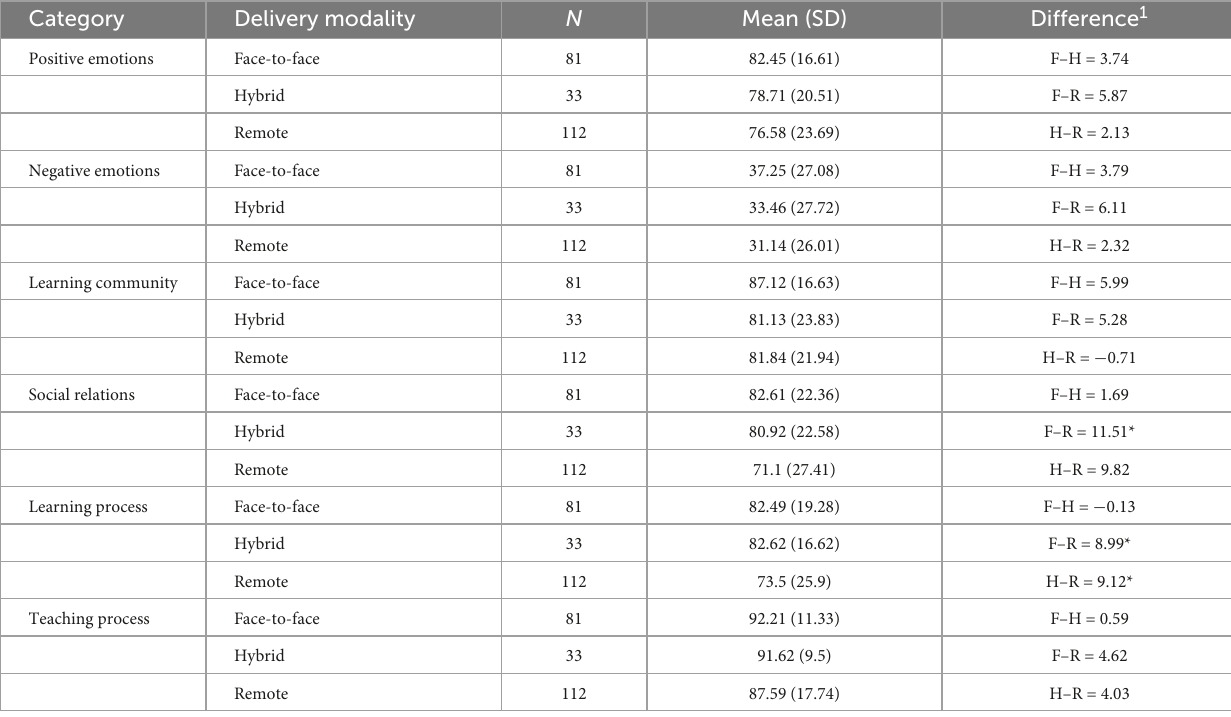
TABLE 2 Comparison of students’ perceptions of delivery